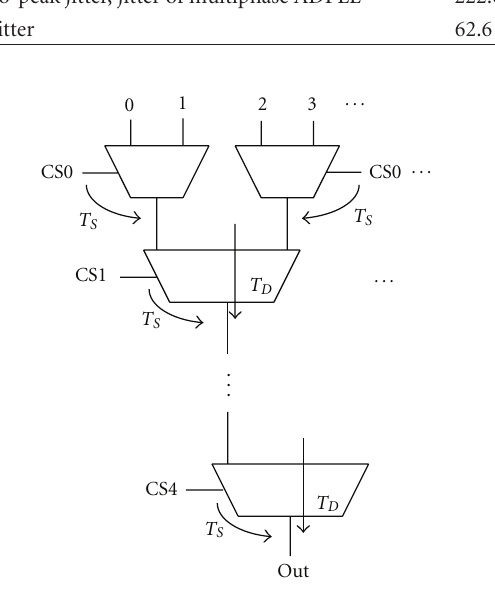
Figure 11: Delay mismatch in 32-to-1 MUX based on tree